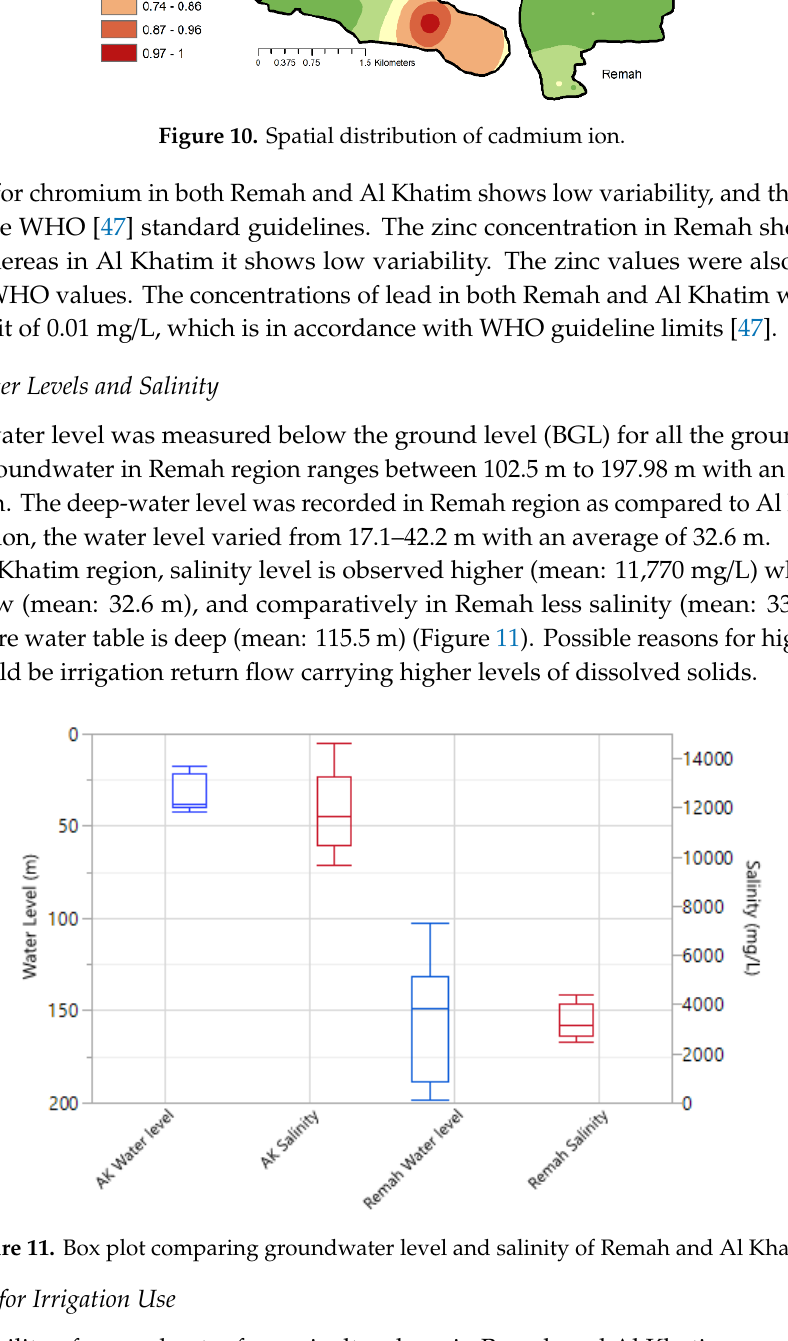
Table 3. Groundwater classification for irrigation use (R: Remah; AK: Al Khatim).